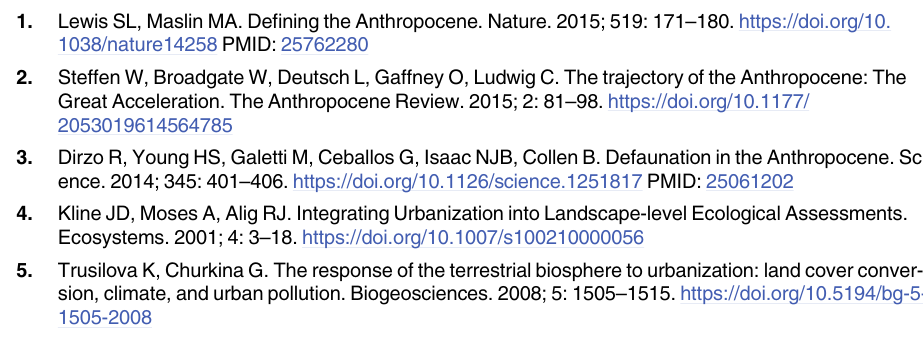
S11 Table. Relative importance of variables within the top models (DAIC < 2, 5 models) for assessing community dissimilarity during the spring season. Below relative importance are the standardized conditional beta estimates for each variable based on the variable’s relative importance across all top models. 95% confidence intervals are shown for each beta estimate in parathesis. The top nine models are displayed below with + indicating the variable is included in the model. Our randomized null model contained variables with estimated relative importance of 0.55, thus variables with a relative importance above 0.55 likely have meaningful predictive power. The variables are listed by relative